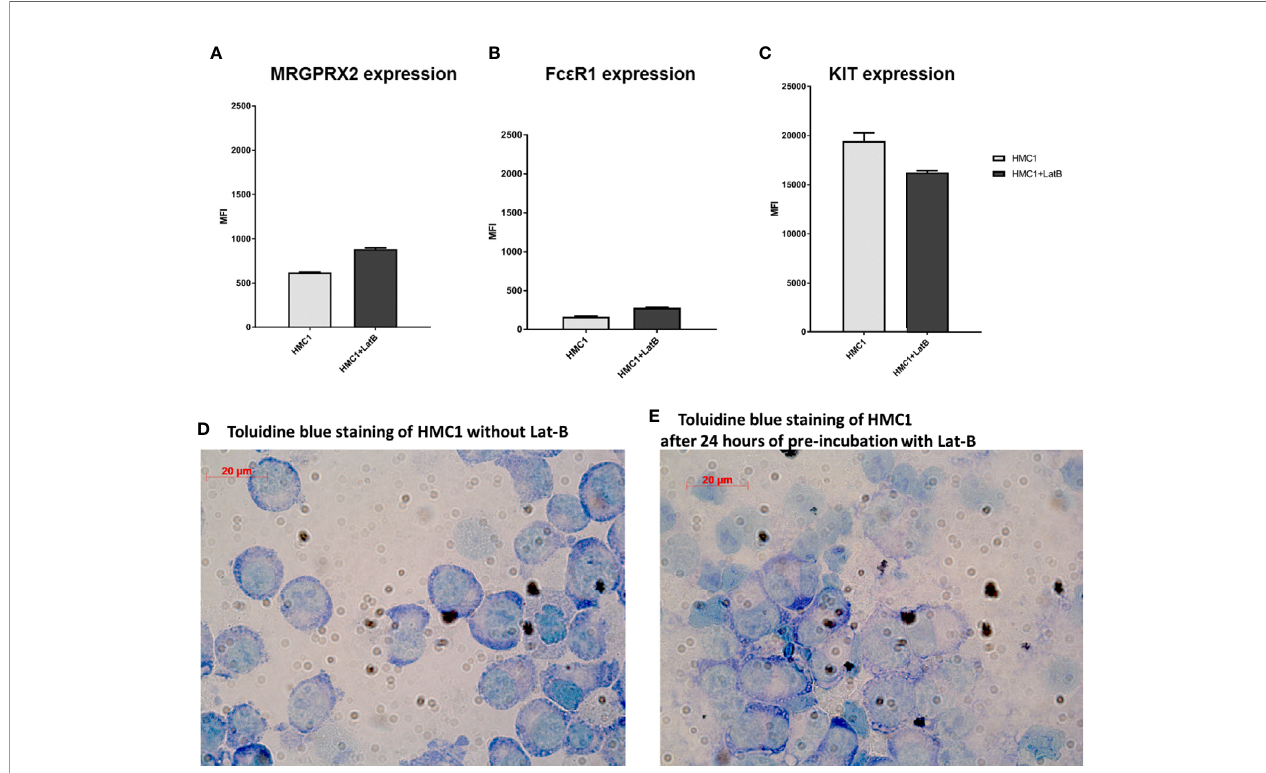
FIGURE 4 | Latrunculin-B does not induce phenotypical changes to HMC1 cells. The receptor expression of HMC1s with and without pre-incubation with 2 µg/ml Lat-B for 24 hours is shown (n=3, Mean Fluorescent Intensity with SEM). The expression of MRGRPX2 (A) and Fc ϵ RI (B) is slightly upregulated after pre-incubation with Lat-B, but not statistically signi fi cant. The expression of KIT is decreased after pre-incubation with Lat-B, but again not statistically signi fi cant (C) . The morphological appearance of HMC1s is not changed upon pre-incubation with Lat-B (D, E) .